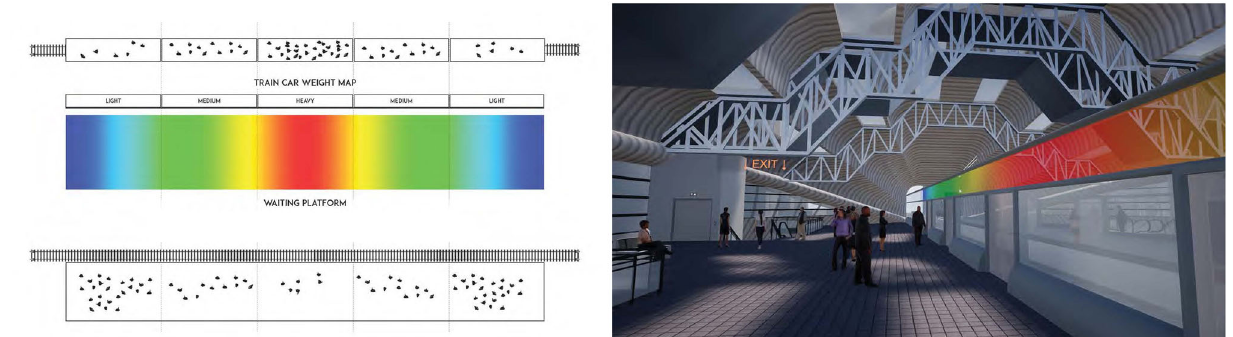
Fig. 7 Placement of color contrast information panel to guide boarding (left: color contrast system to guide passengers for boarding; right: placement of information panel). By Tyler Dunn